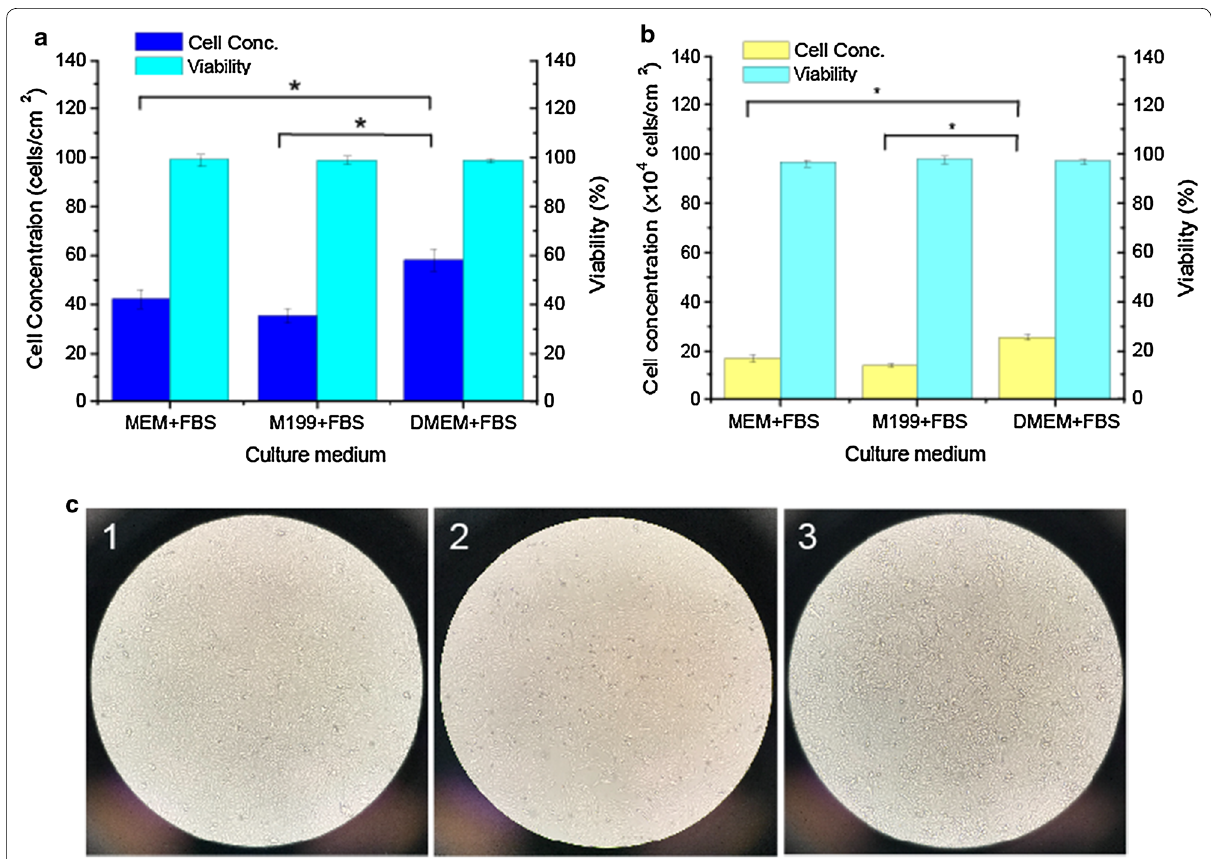
Fig. 2 Cell culture media screening results. a Comparison of HEK293T cell growth in different culture media (n growth in different culture media (n